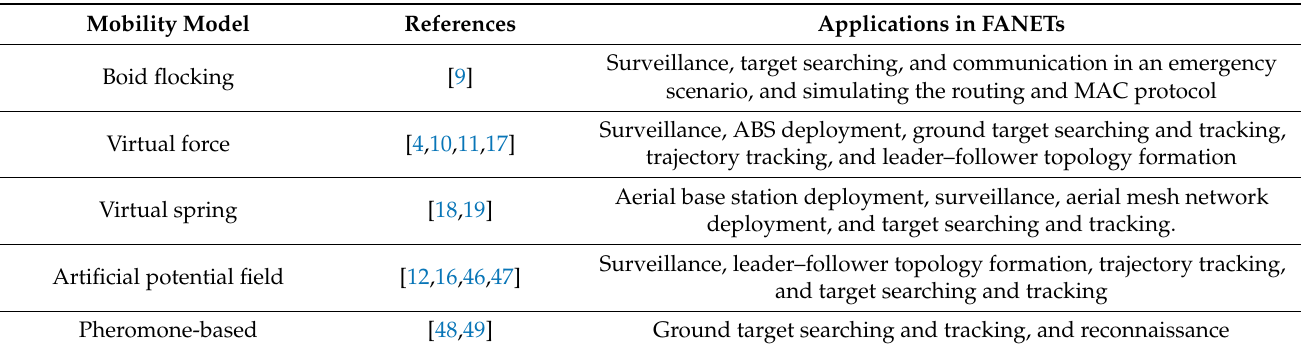
Table 5. Summary of realistic mobility models in FANETs according to applications.